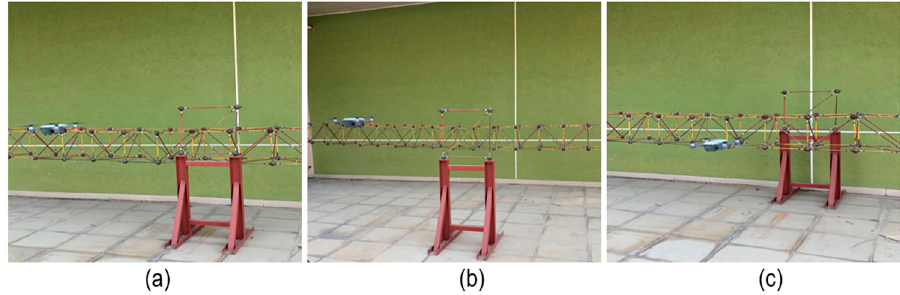
Figure 9. Positions of the fixed object: ( a ) Zw = 0 m; ( b ) Zw = 1 m; ( c ) Zw = –1 m.